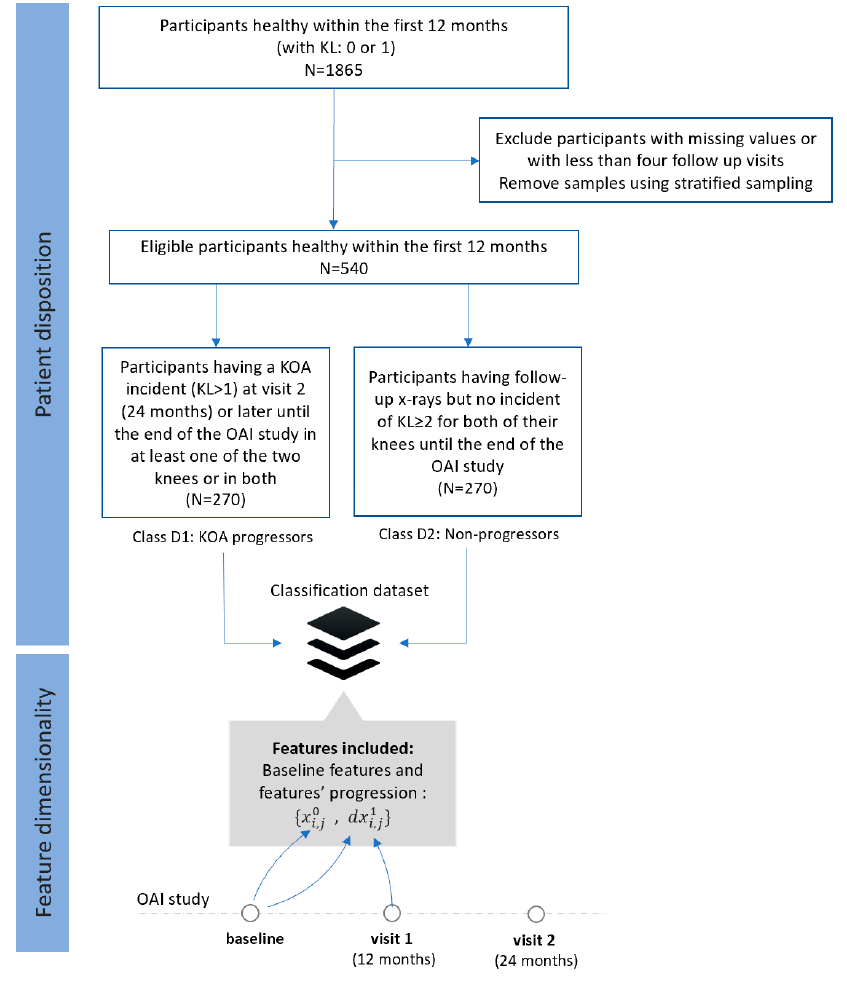
Figure 4. Flow chart of study design for dataset D.